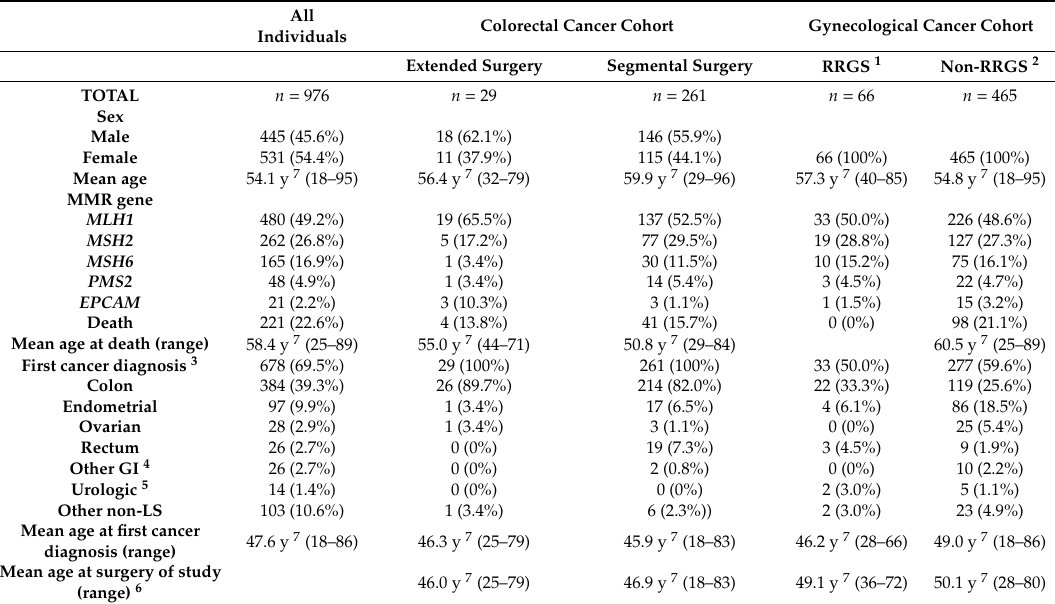
Table 1. Patient